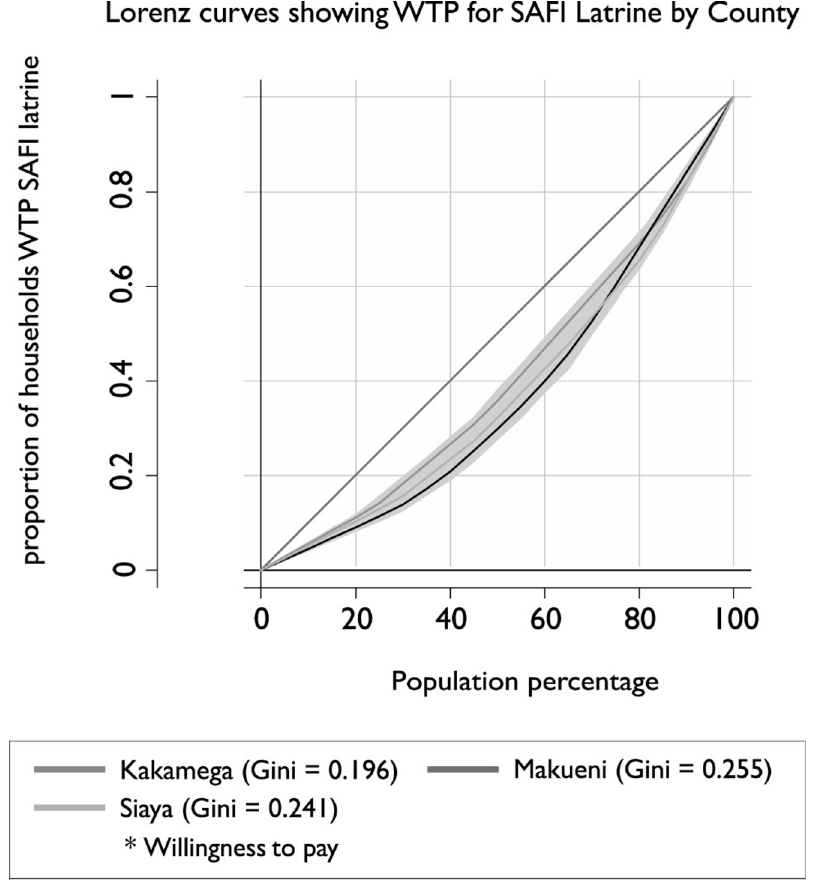
Fig 6. Lorenz curves showing wealth inequality for SAFI in study